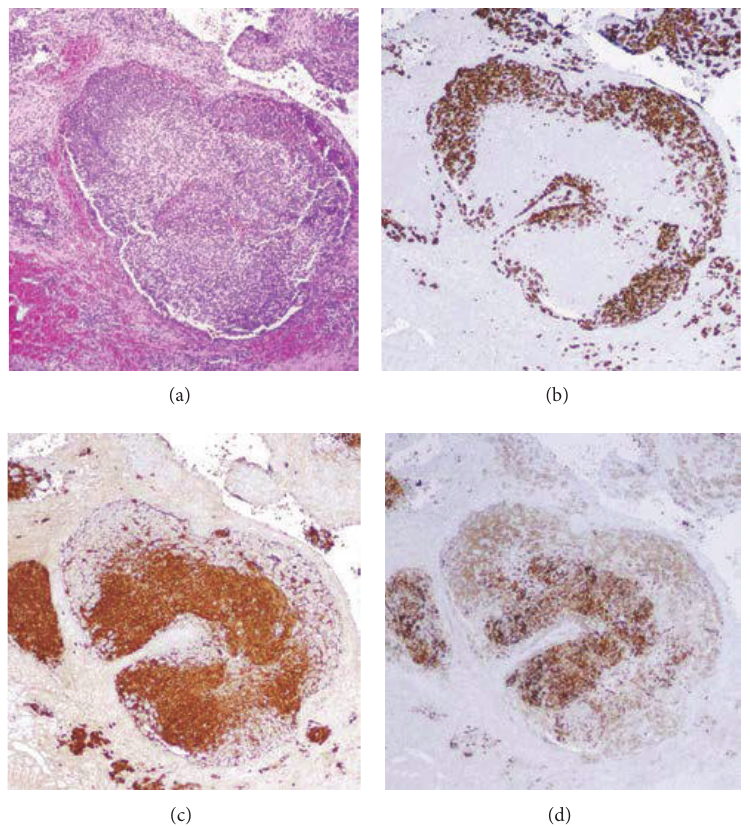
Figure 4: Immunohistochemical features of tumor in the left inguinal lymph node. (a) Microscopic photographs from left inguinal lymph node biopsy reveal primitive tumor cells with nodular growth pattern. The tumor cells demonstrate immunohistochemical reactivity for (b) myogenin, (c) PGP9.5, and (d) tyrosine-hydroxylase to show both myogenic and neural differentiation (original magnification × 200 (a–d)).